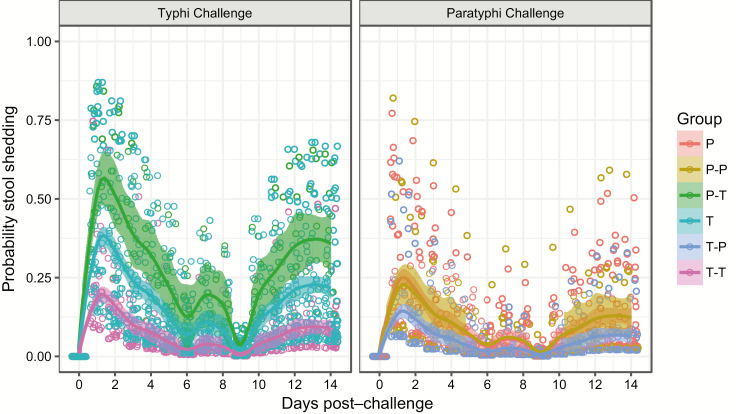
Bacterial shedding in stool after S. Typhi or S. Paratyphi challenge, according to previous exposure. P = S. Paratyphi naive (n = 39); P-P = S. Paratyphi rechallenge after previous S. Paratyphi exposure (n = 13); P-T = S. Typhi challenge after previous S. Paratyphi exposure (n = 10); T = S. Typhi challenge in S. Typhi naive participants (n = 71); T-P = S. Paratyphi challenge after previous S. Typhi exposure (n = 27); T-T = S. Typhi rechallenge after previous S. Typhi exposure (n = 27). See Supplementary Table S1 for model outputs.